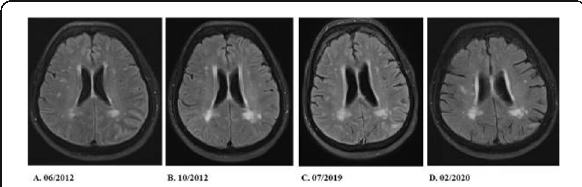
Fig. 1 (abstract P0123). progressive diffuse signal abnormalities of white matter over 7-year period (A-C) with gradual resolving after